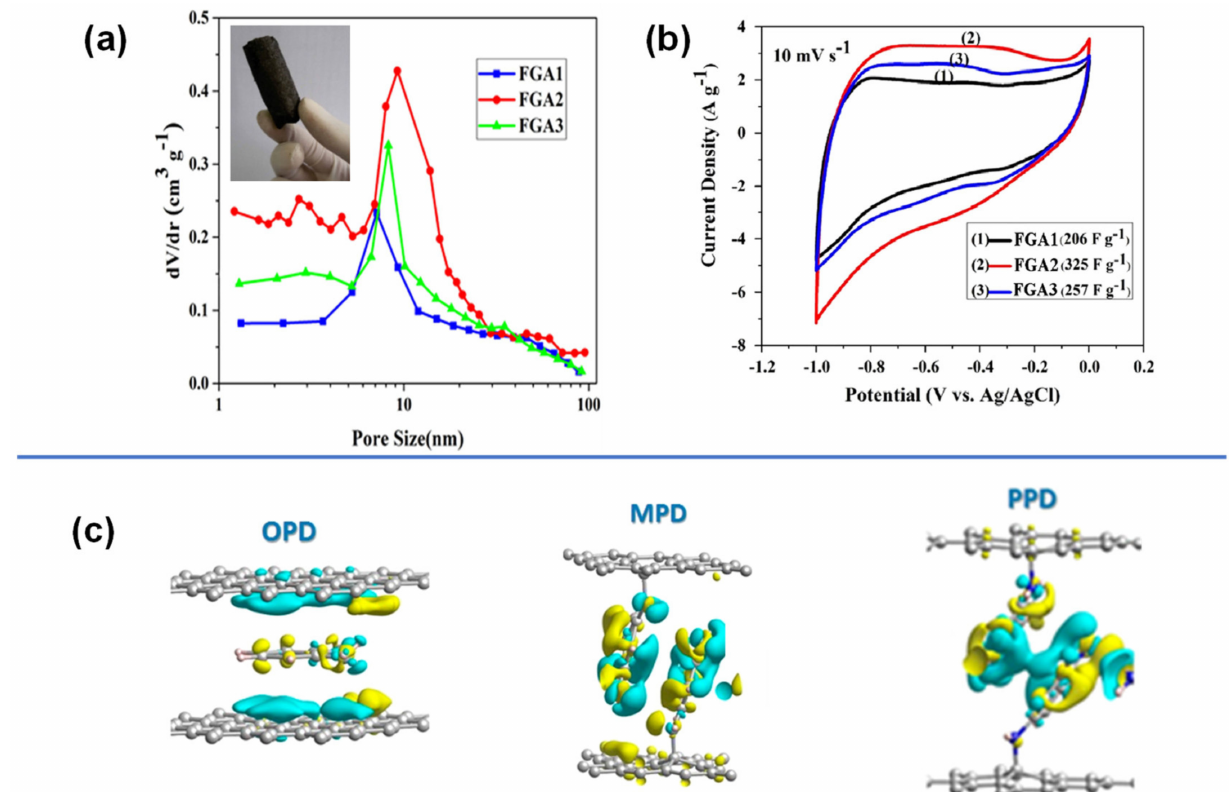
Figure 9. ( a , b ) Pore size distribution and CV profile at 10 mV/s of p-PD functionalized graphene aerogel (FGA), ( c ) o, m, p-PD isomers intercalated between graphene sheet Reproduced with permission from Refs. [48,167].